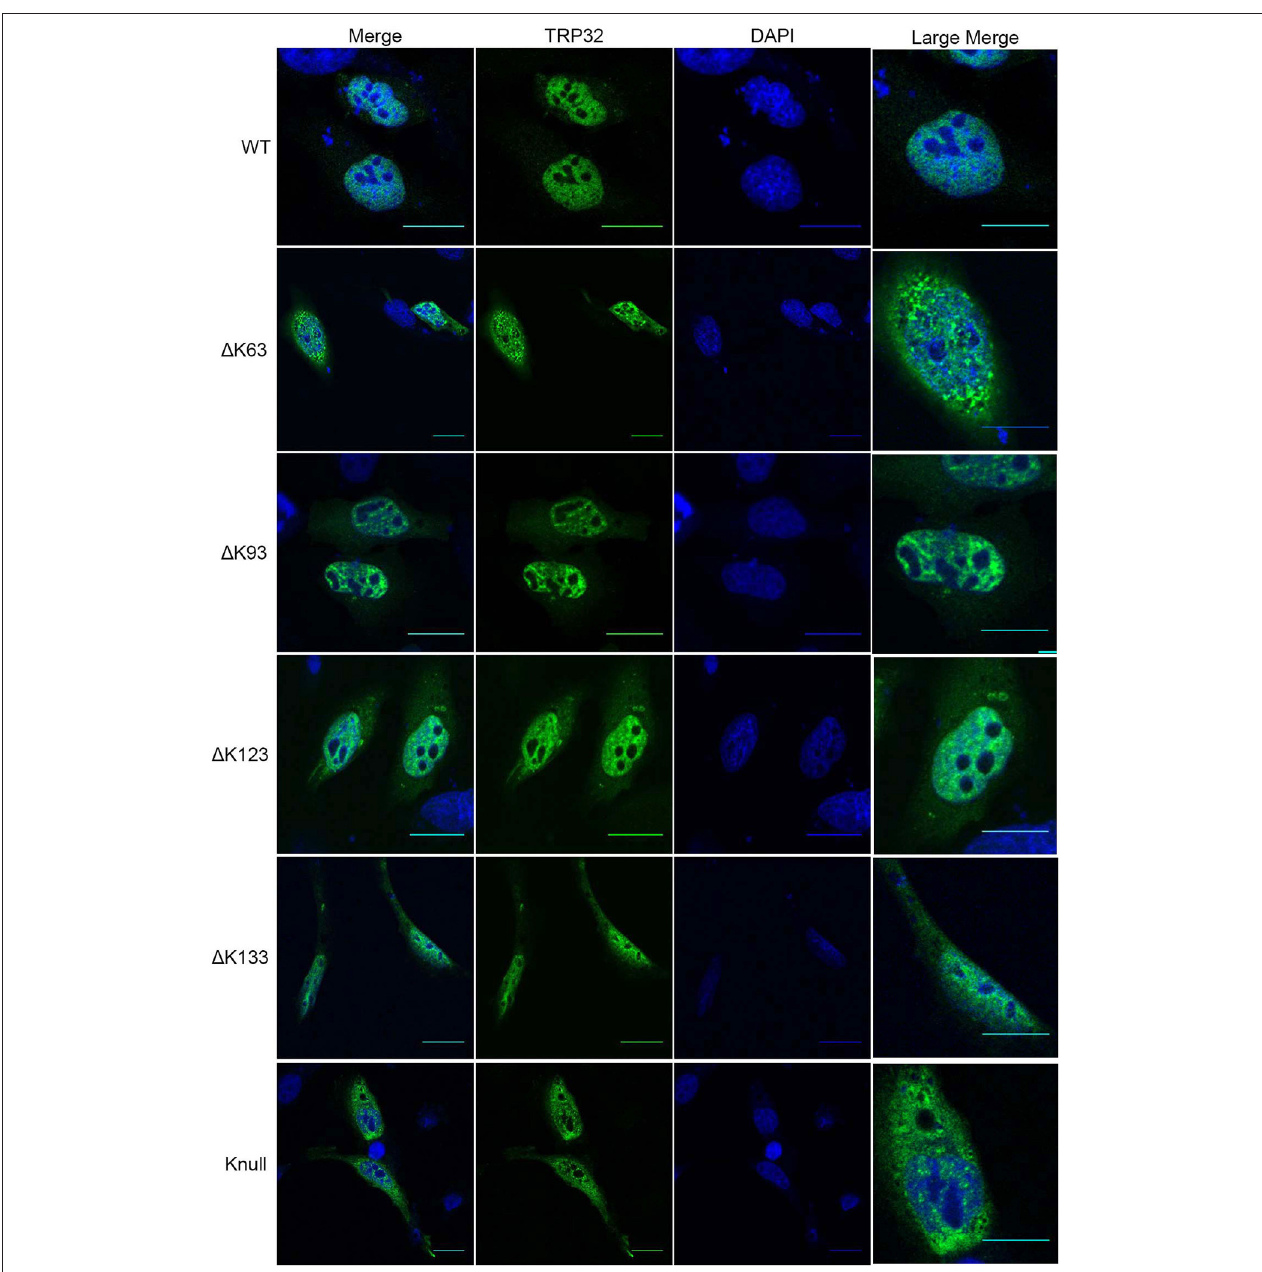
FIGURE 6 | TRP32 lysine mutants demonstrate altered subcellular localization of GFP-tagged TRP32. HeLa cells were transfected with WT and lysine mutant GFP-tagged TRP32. At 24h post-transfection cells were fixed and visualized using confocal microscopy. Nuclei are stained blue (DAPI).